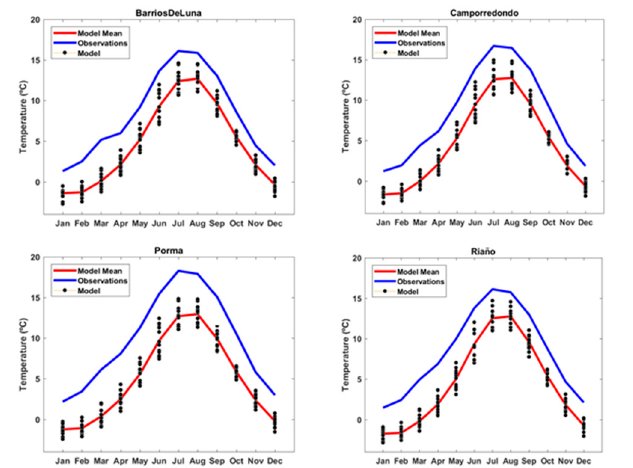
Figure 2. Comparison of monthly mean temperatures supplied by climate models and observations in the control period. Blue lines are observations. Red lines represent the median of the 12 climate models considered.